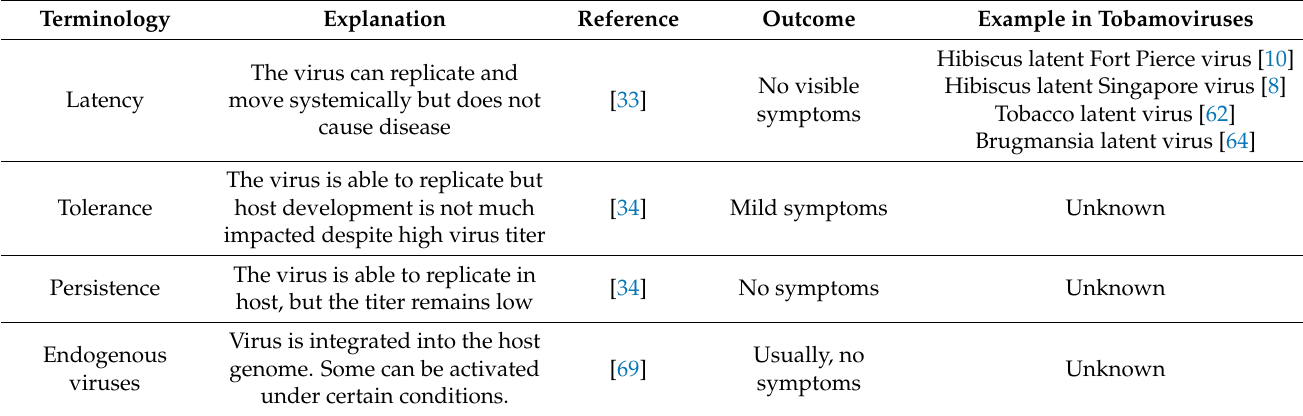
Figure 6. Overview of severe, mild and latent infections in different plant families caused by tobamoviruses mentioned in Figure 5. Severe, mild and latent infections have been defined based on the symptoms caused by the original host plant for each virus. It highlights the abundance of virus species and knowledge related to solanaceous-infecting tobamovirus and lack of studies on ornamental and wild host plants.